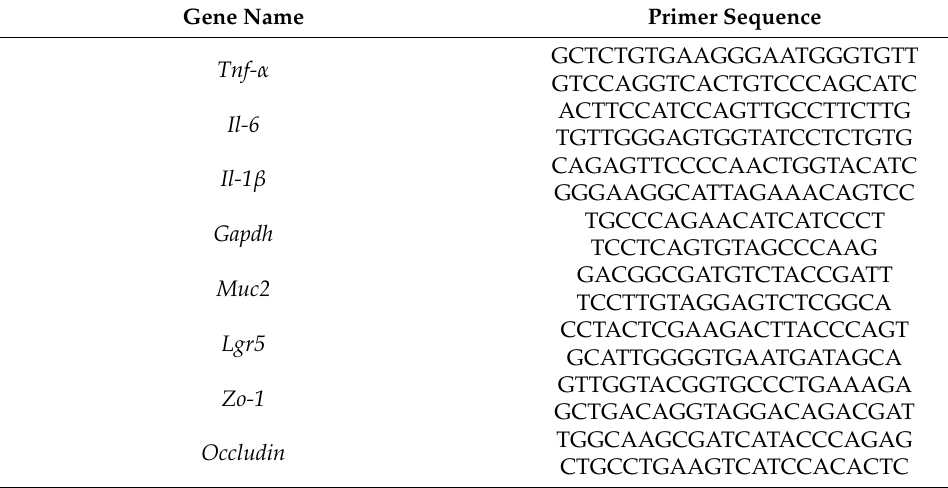
Table 1. Primers used in real-time